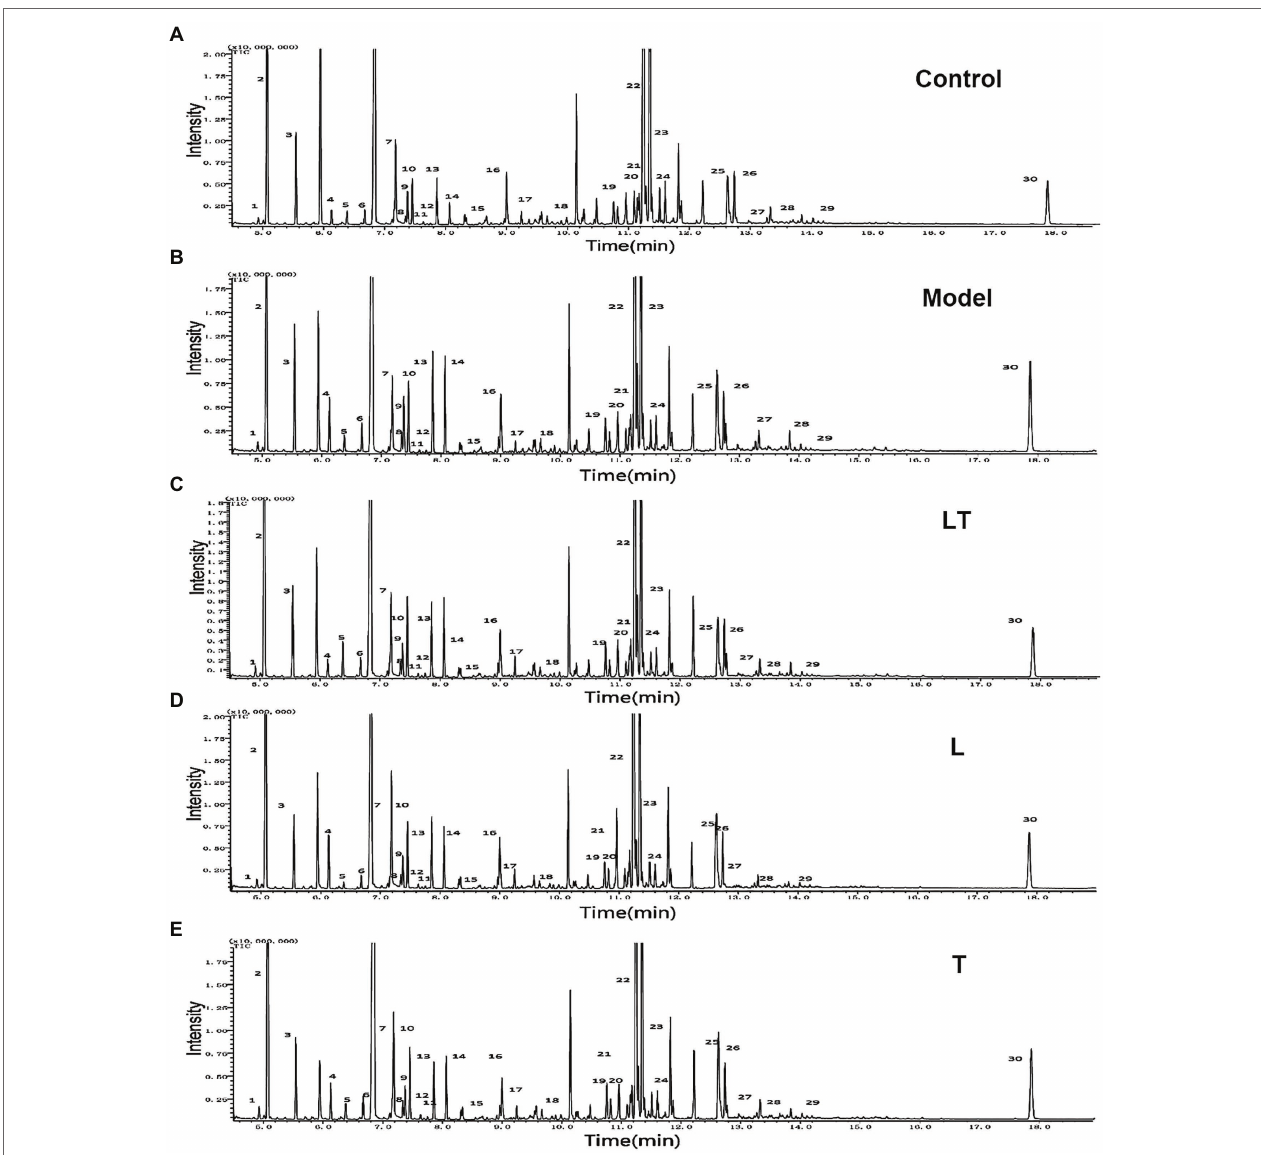
FIGURE 2 | Typical GC/MS chromatograms of cardiac tissue extracts in (A) the control group; (B) the high-altitude myocardial injury (HAMI) model group; (C) the LT group; (D) the l -carnitine group; and (E) the trimetazidine group. Visual inspection of the chromatograms revealed obvious differences between the groups. L: l -carnitine; T: trimetazidine; LT: l -carnitine combined with trimetazidine. The compounds were identified as 1. pyruvate; 2. lactate; 3. alanine; 4. 3-hydroxybutyrate; 5. urea; 6. valine; 7. leucine; 8. isoleucine; 9. proline; 10. glycerate; 11. fumarate; 12. serine; 13. succinate; 14. malate; 15. 2-ketoglutaric acid; 16. asparagine; 17. taurine; 18. citrate; 19. fructose; 20. glucose; 21. lysine; 22. tyrosine; 23. octadecadienoate; 24. oleic acid; 25. tryptophan; 26. arachidonic acid; 27. D-mannose-6- phosphate; 28. docosahexaenoic acid; 29. D-galactofuranose; and 30.